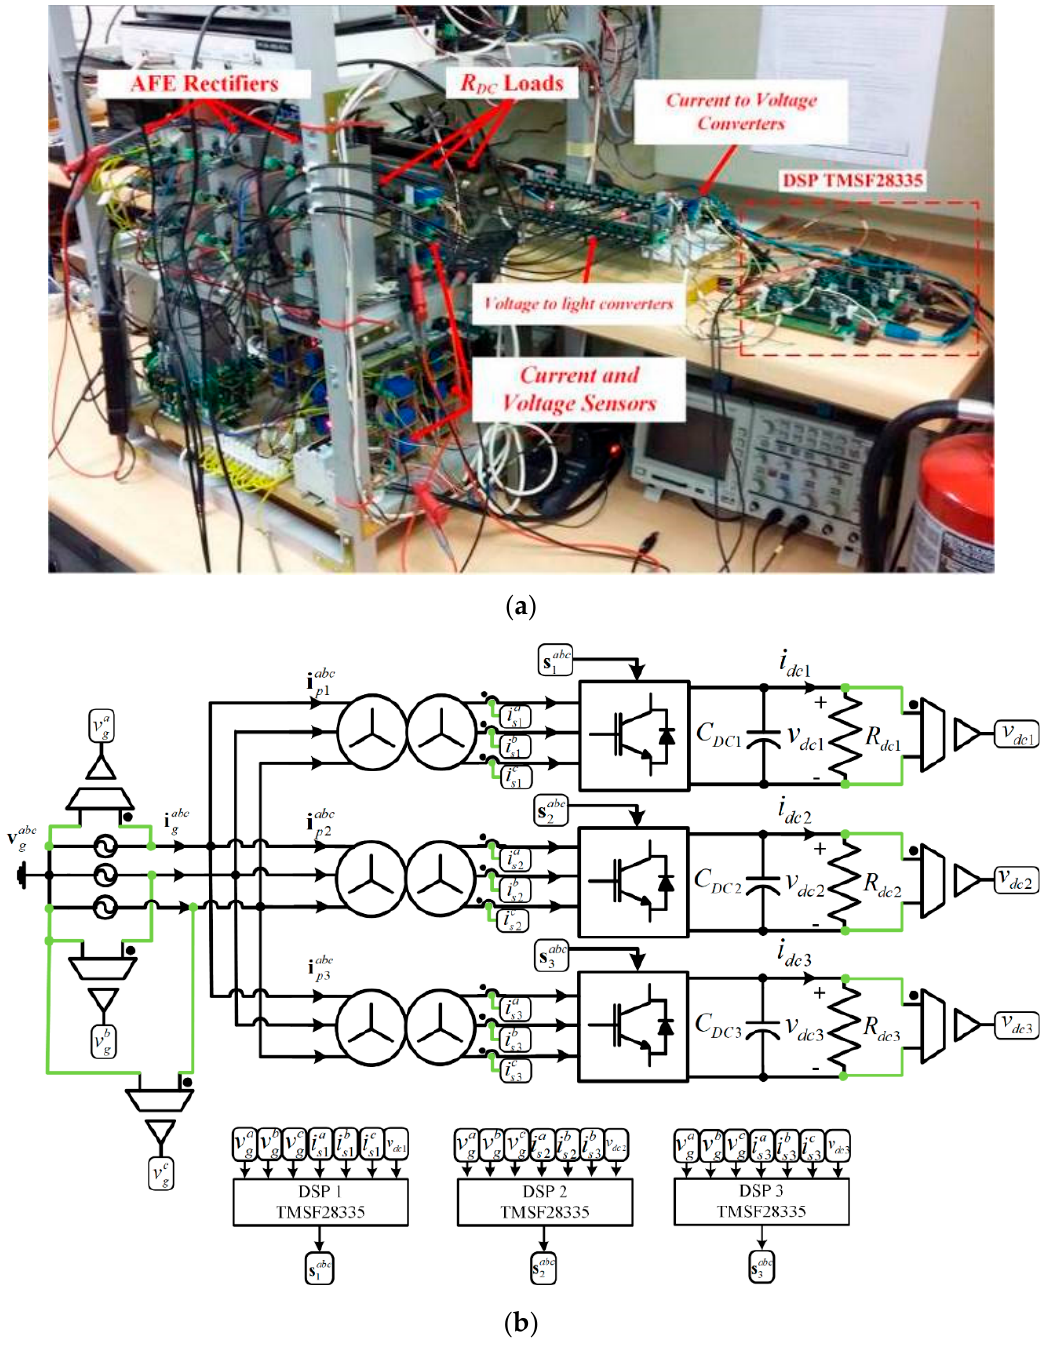
Figure 5. Experimental setup, ( a ) low power prototype multicell AFE rectifier, ( b ) Input/output signals block diagram of experimental setup.